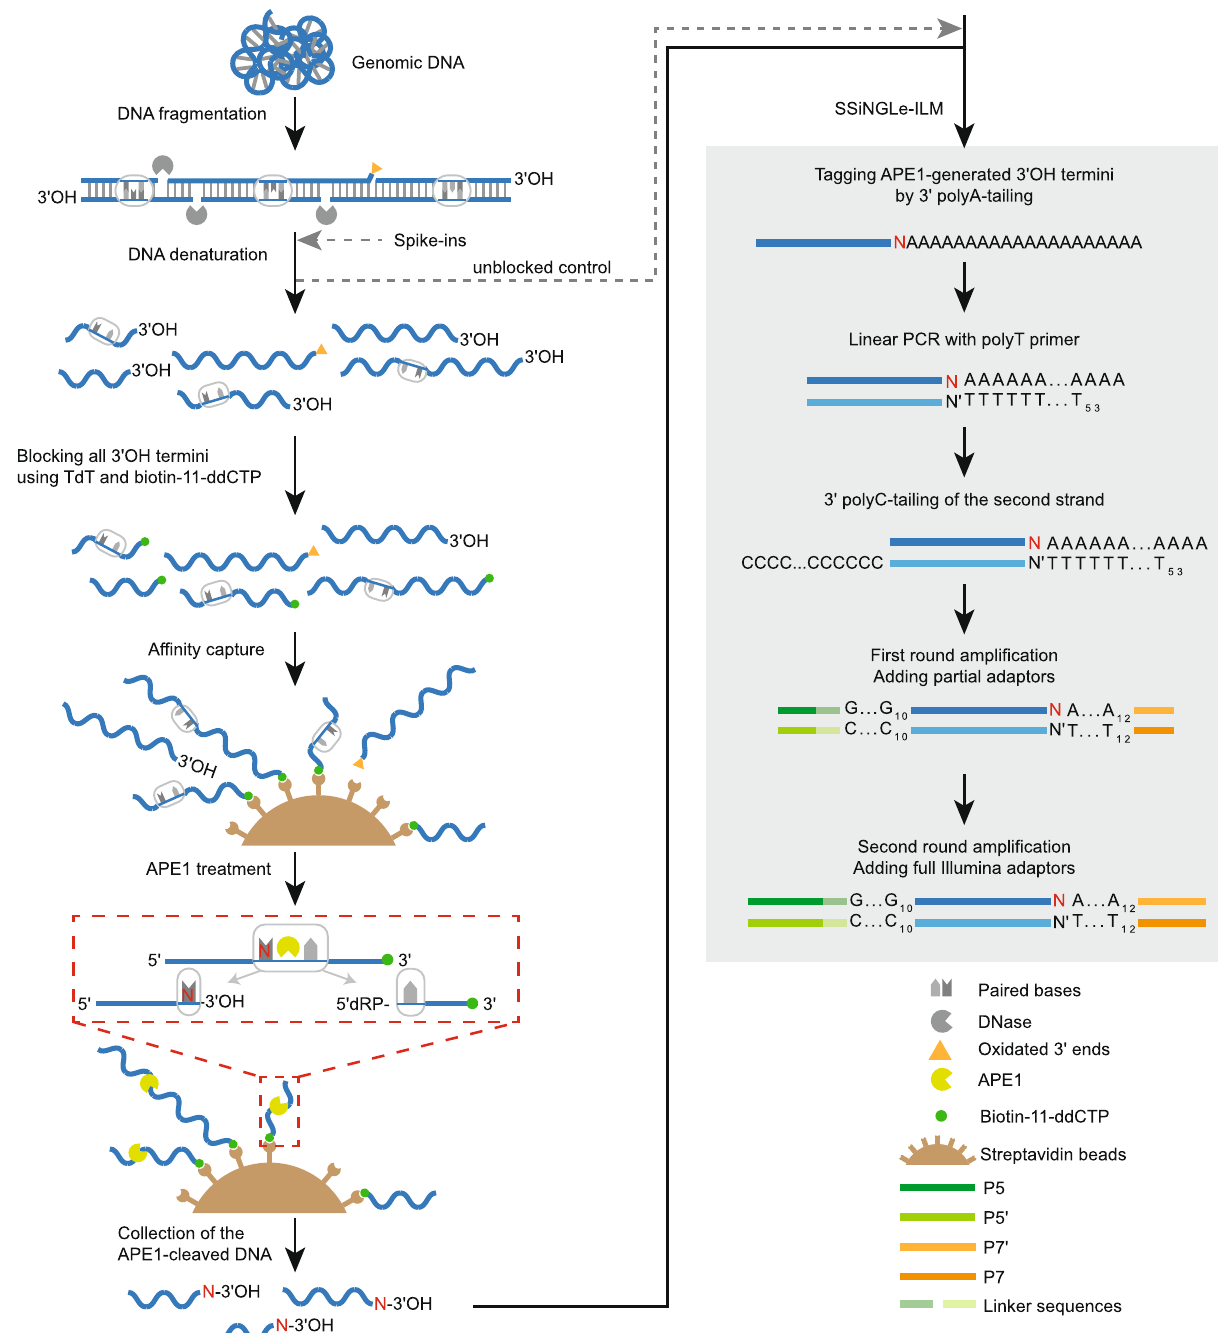
Fig. 1 | Schematics of SSiNGLe-AP. Work fl ow of the molecular biological part of SSiNGLe-AP starting with fragmentation of genomic dsDNA using DNase, followed by denaturation, blocking of all 3 ’ OH termini of ssDNA molecules using TdT (terminal transferase) and biotin-11-ddCTP, and subsequent af fi nity capture of 3 ’ - blockedandbiotinylatedfragments(allsymbolsareexplainedinbottomright)that werethensubjectedtoAPE1treatmentthatreleasesssDNAfragments,inwhichthe 3 ’ OH termini correspond to Ns — the nucleotides immediately upstream of the corresponding AP sites. The freed fragments were then subjected to the SSiNGLe